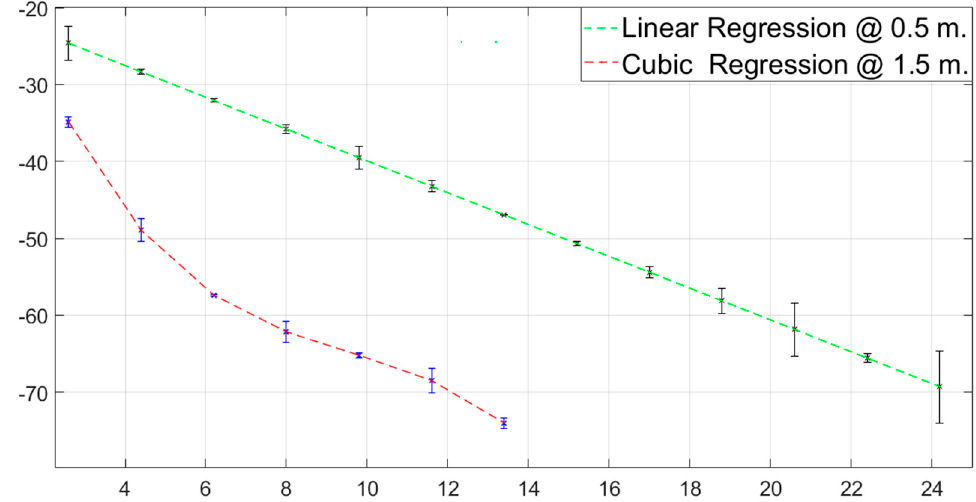
Figure 8. Linear and cubic regression for measurement at 0.5 m and 1.5 m respectively along with its deviation. Table 3. Percentage of error in the 2.4 GHz band with propagation models in the presence of vegetation when the Tx and Rx nodes were 0.5 m above the ground.